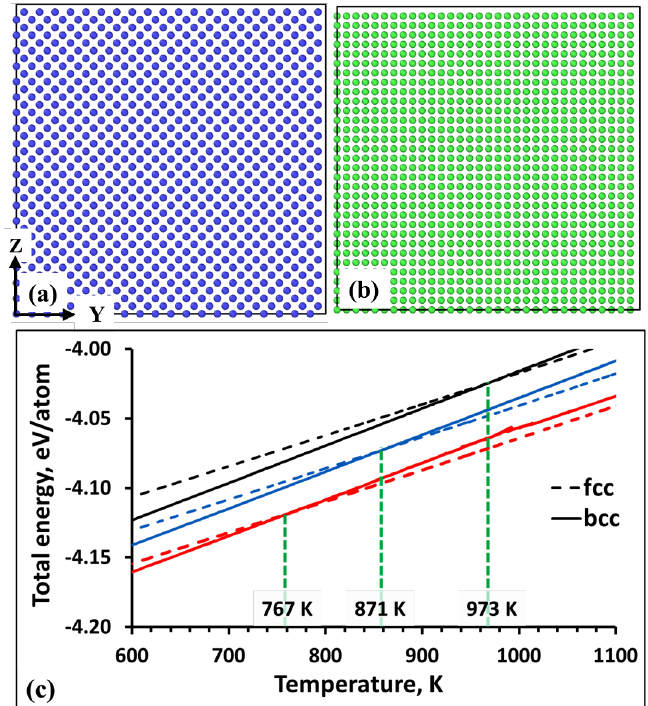
Figure 6. The single crystal ( a ) fcc and ( b ) bcc phases without pre-existing defects of pure Fe at 0 K used for analysis of total energy as a function of temperature. Atoms are coloured by a-CNA: green—fcc, blue—bcc. ( c ) The total energy of the single crystal fcc (dashed lines) and bcc (solid lines) without pre-existing defects as a function of temperature for pure Fe (black), Fe-0.25 at. %C (blue), and Fe-0.5 at. %C